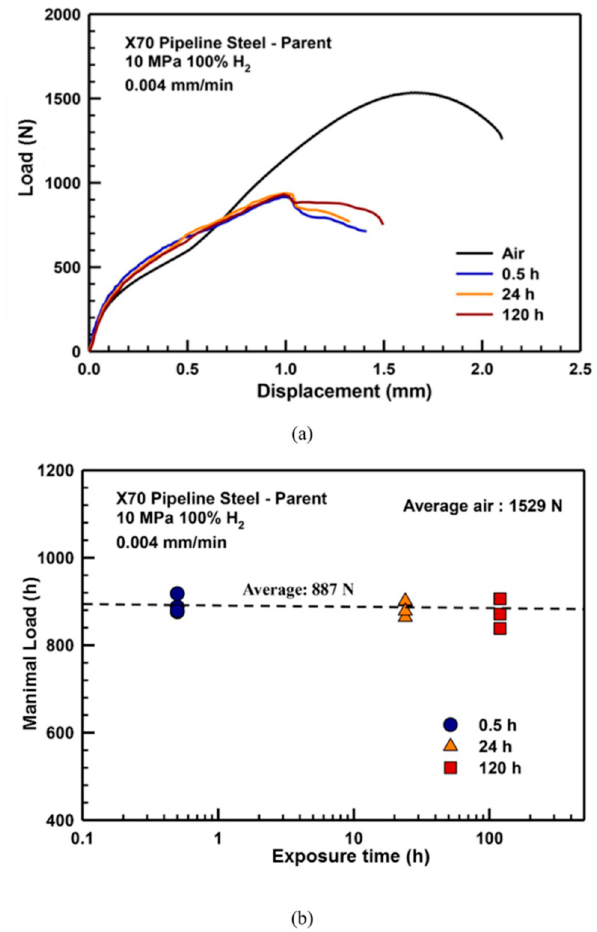
Figure 11. Influence of hydrogen exposure time on SP test results: ( a ) comparison of typical load– punch displacement curves, ( b ) maximal load with respect to exposure time [53].